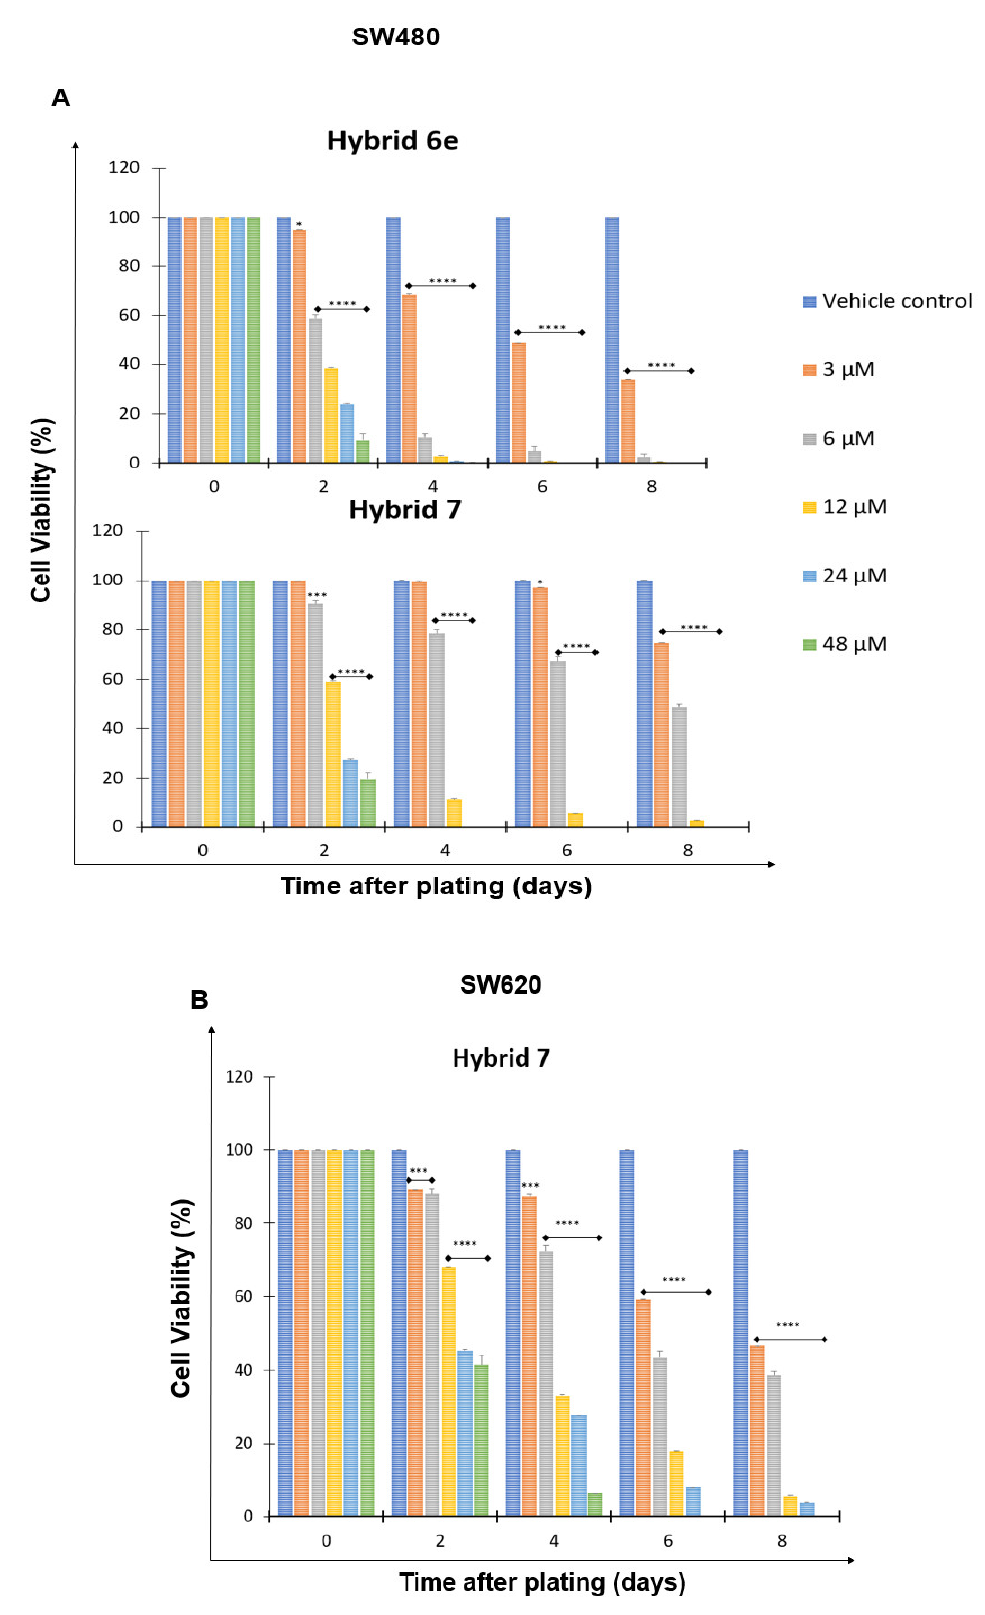
Figure 3. Antiproliferative effect of resveratrol/hydrazone hybrids on SW480 ( A ) and SW620 ( B ) cells. Results obtained with sulforhodamine B assay. DMSO 1% was used as a control. Data are presented as the mean ± SE of at least three independent experiments. * p < 0.05; *** p < 0.001; **** p < 0.0001.